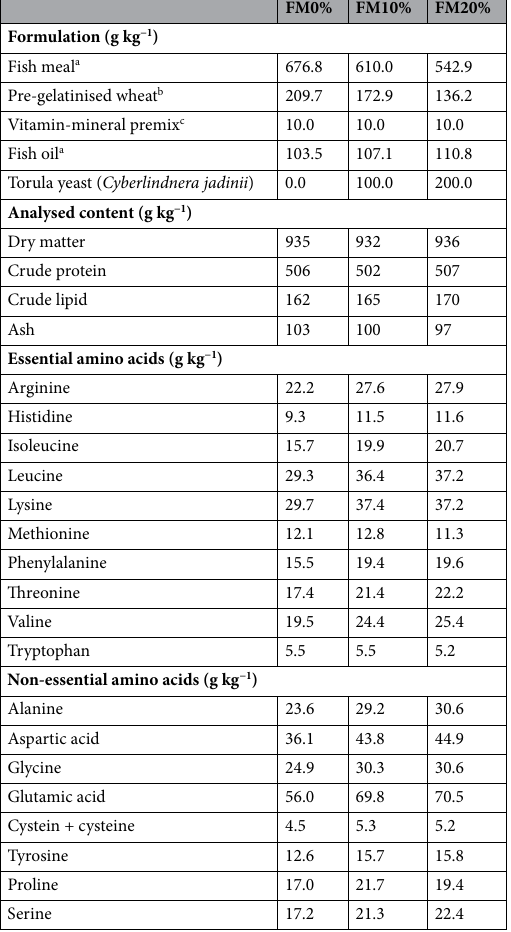
Table 1. Feed formulation and chemical composition for marine protein (FM) feed treatments. a Laxá hf. Krossanes, Iceland. b Emmelev A/S, Denmark. c Laxa salmon premix 2006 1%, Trouw Nutrition, The